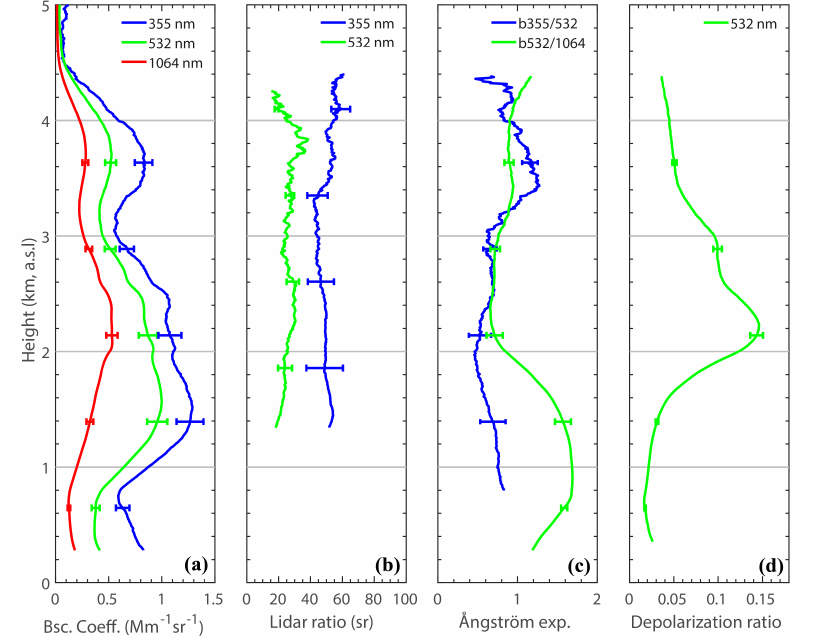
Figure 5. ( a ) Particle backscatter coefficients (at three wavelengths), ( b ) the extinction-to-backscatter ratios, ( c ) the corresponding backscatter-related Ångström exponents and ( d ) particle linear depolar- ization ratios measured at Punta Arenas on 5 February 2019, 07:51–08:57 UTC. Error bars depict the estimated